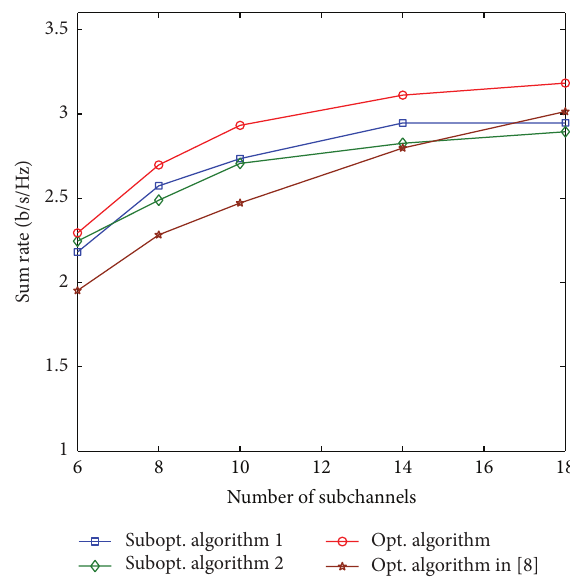
Figure 4: Sum rate versus the number of subchannels. 87 % of the corresponding optimal solution, respectively.